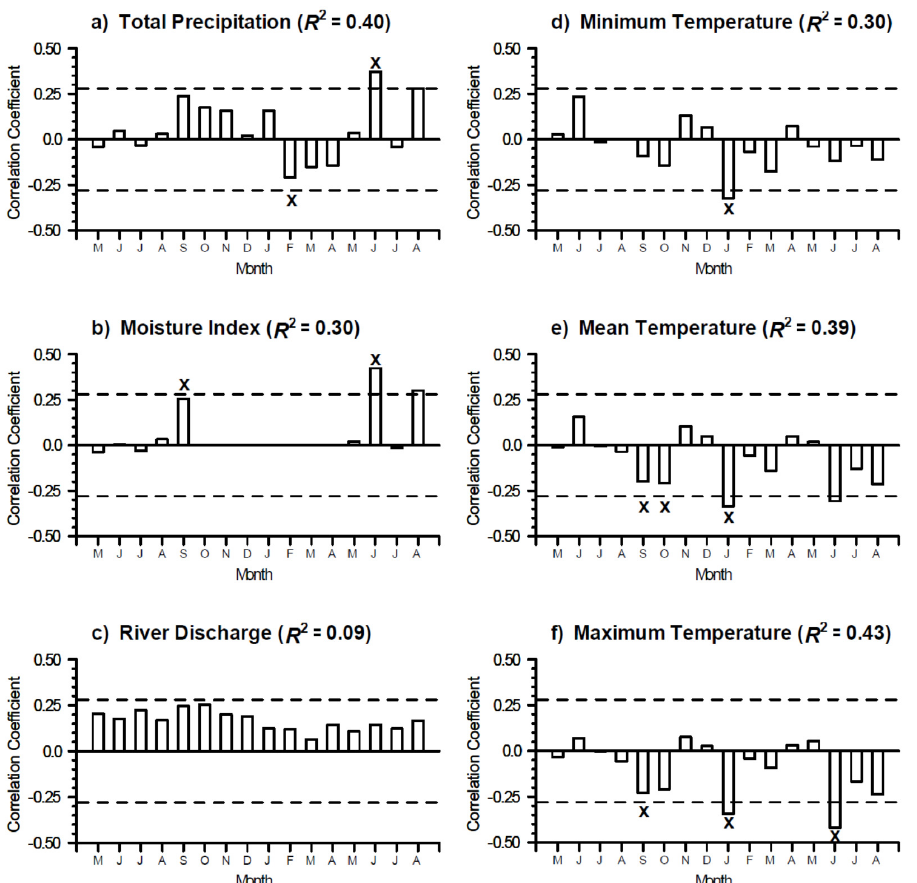
Figure 4. Pearson correlation coefficients between the residual chronology of trembling aspen and ( a ) total precipitation; ( b ) moisture index; ( c ) river discharge; ( d ) minimum temperature; ( e ) mean temperature; and ( f ) maximum temperature. Significant correlations ( p < 0.05) determined from correlation analysis extend past dashed lines. Significant climatic variables ( p < 0.05) determined from the response function analysis are denoted with an X. The R 2 value of the response function model for each climate variable is indicated. Table 2. Pearson correlation coefficients between the residual chronology of white spruce and trembling aspen with the annualization periods of climatic variables. Total Precip. River Discharge Min. Temp. Mean Temp. Max. Temp. Total